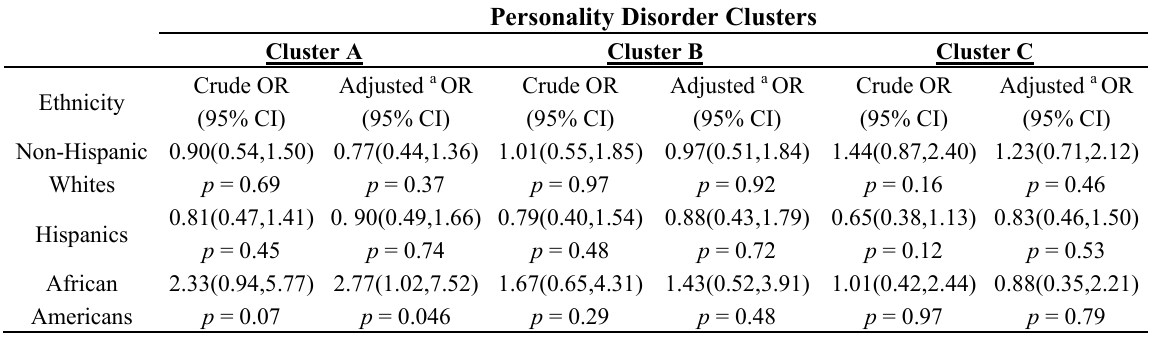
Table 3. Associations among personality disorder clusters and ethnicities in a group of women veterans diagnosed with PTSD.